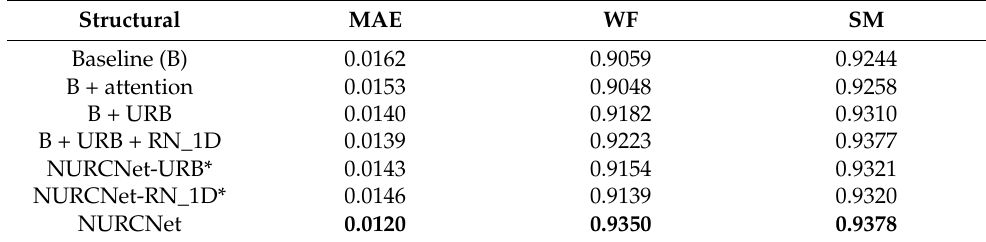
Table 1. The results of using different key components.